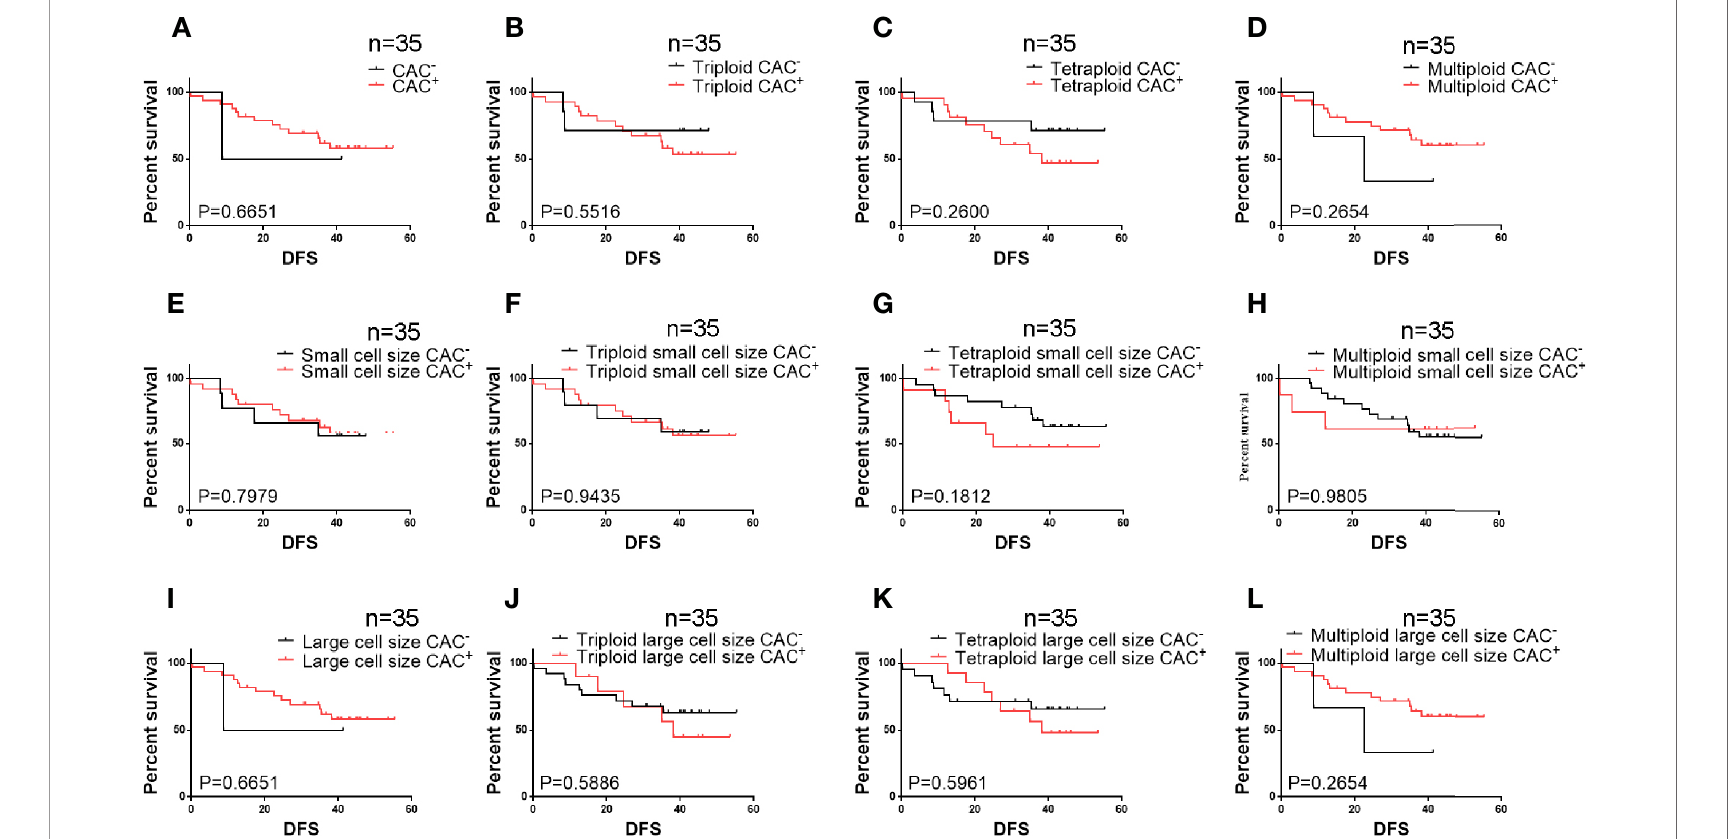
FIGURE 3 | Survival analysis of post-surgery CACs among 35 patients (A – D) Total circulating aneuploid cells (CACs) and triploid, tetraploid, and multiploid CAC subtypes were not correlated to DFS (P > 0.05). (E – H) Total small cell size CACs and triploid, tetraploid, and multiploid small cell size CAC subtypes were not correlated to DFS (P > 0.05). (I – L) Total large cell size CACs and triploid, tetraploid, and multiploid large cell size CAC subtypes were not correlated to DFS (P >